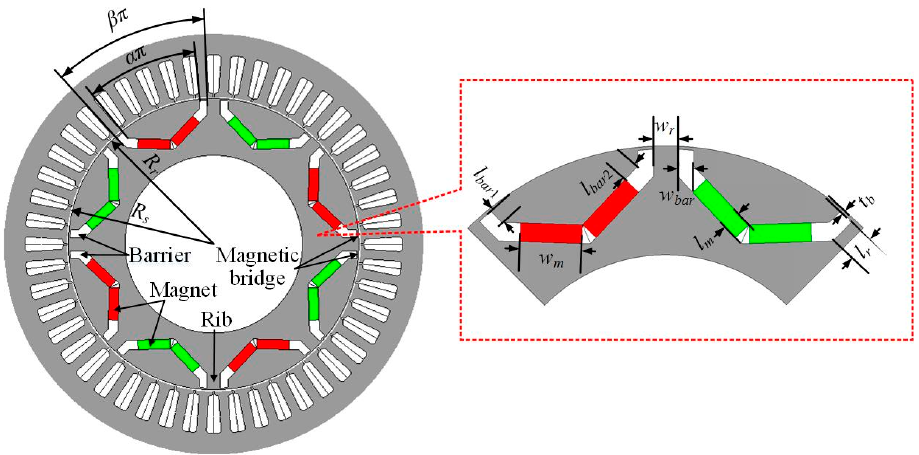
Figure 1. Model of a 48 ‐ slot/8 ‐ pole Interior permanent magnet (IPM) motor.